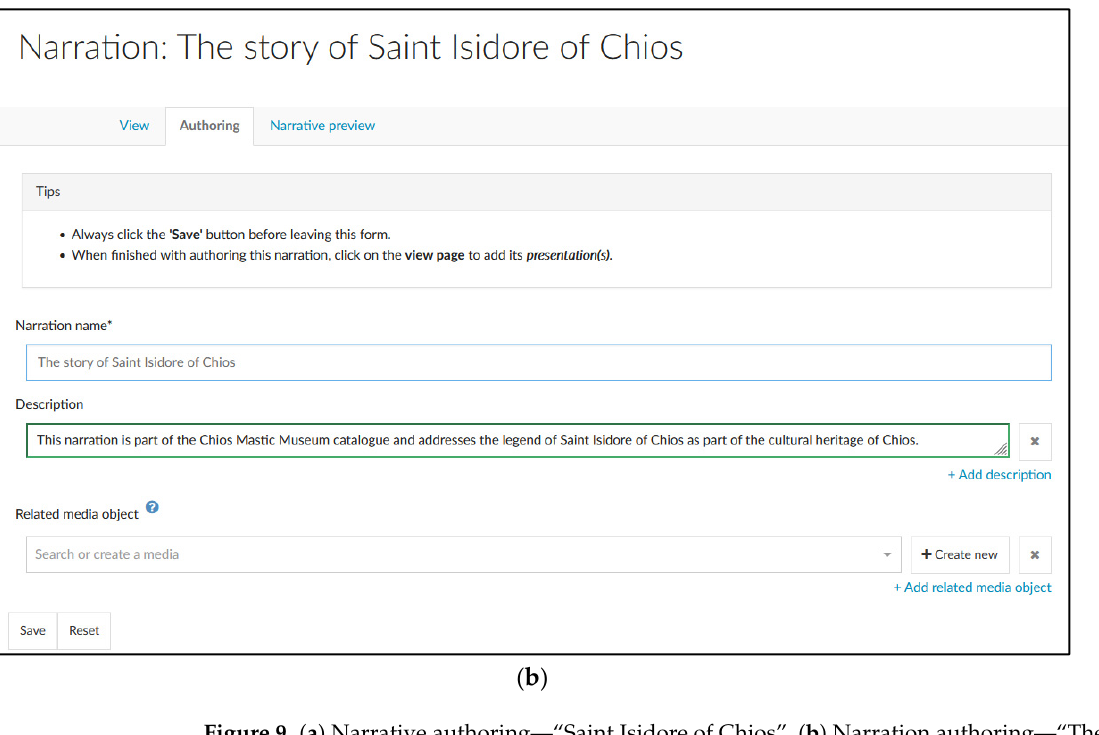
Figure 9. ( a ) Narrative authoring—“Saint Isidore of Chios”, ( b ) Narration authoring—“The story of Saint Isidore of Chios”.